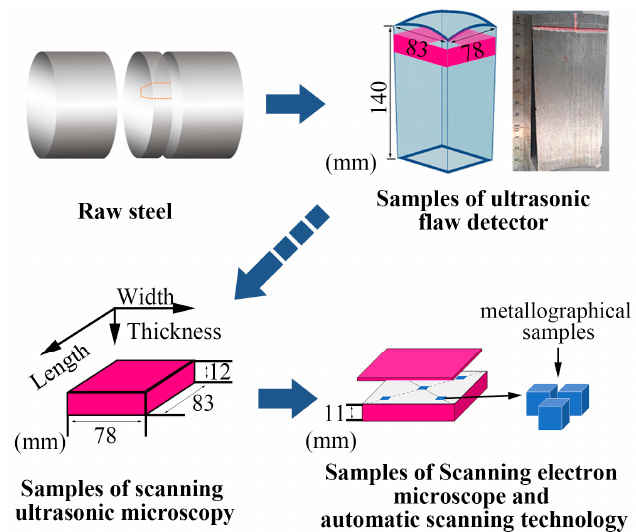
Figure 1. Experimental sample preparation process.